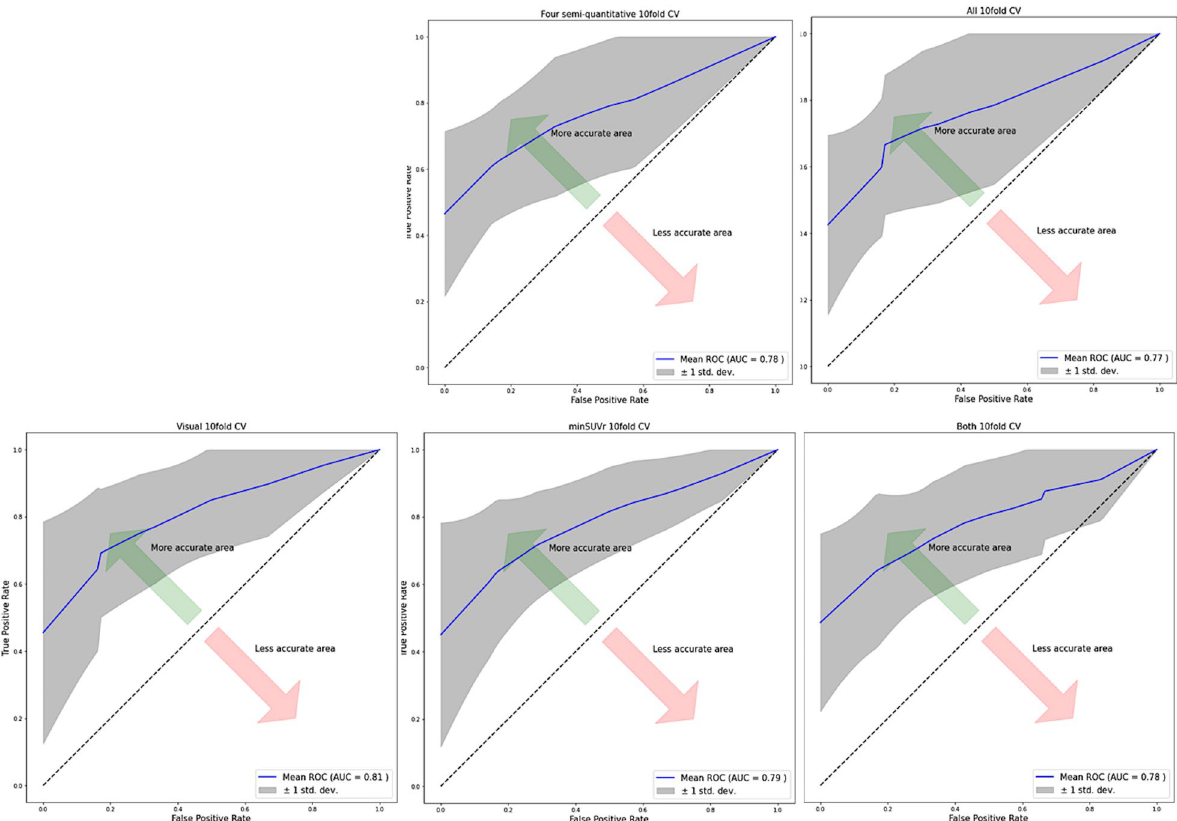
Fig. 8 ROC curves comparison. Left panel: best model AUC (tenfold cross-validated) with visual PET metric alone; middle panel: best model AUC (tenfold cross-validated) with min SUVr PET metric alone; and right panel: best model AUC (tenfold cross validated) with both visual and min SUVr PET metrics. The visual mean AUC of visual and min SUVr were similar (0.81). Combining the two parameters did not improve the overall accuracy